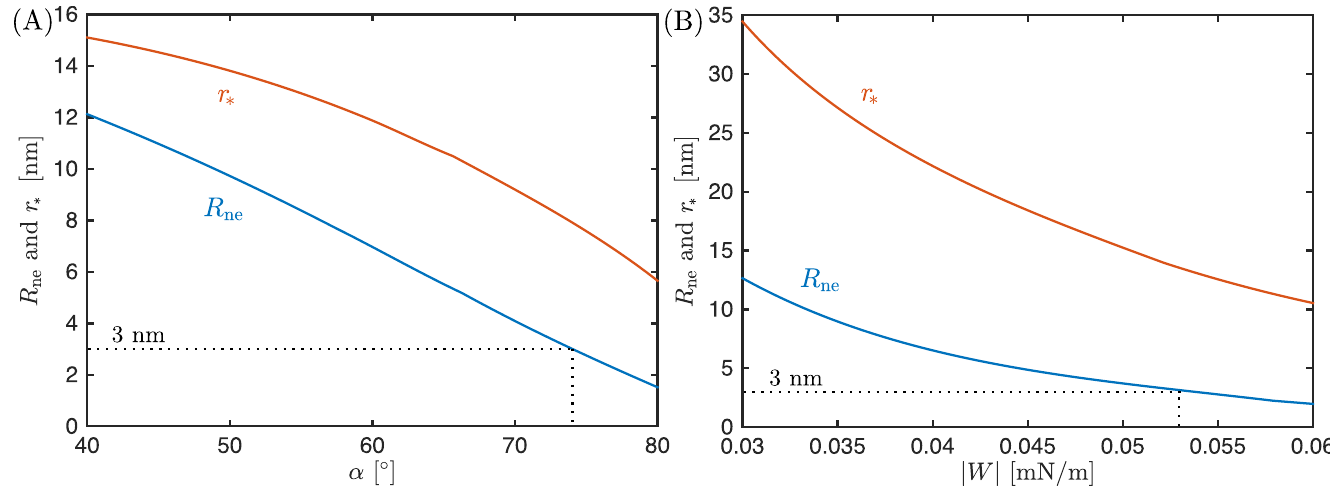
Fig 5. Evolution of the neck radius R ne and the attachment radius r (cid:3) for cone-shaped assemblies. (A) As a function of the cone apex angle α for fixed membrane– protein adhesion strength | W | = 0.2 mN/m; and (B) as a function of the adhesive strength | W | for fixed cone apex angle α = 90˚, i.e. for a fully flattened cone. The neck will close and scission will occur when the neck radius reaches R ne = 3 nm, indicated by the dotted line. In both (A) and (B), the bud radius is R bu = 42 nm.